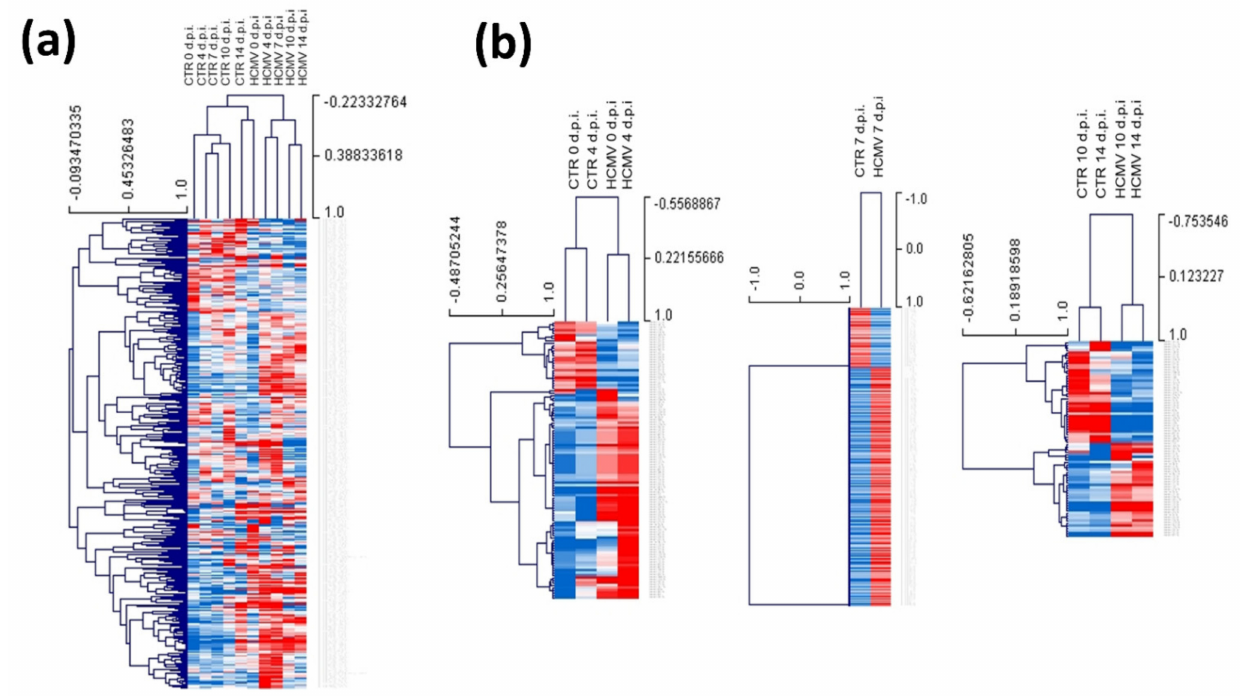
Figure 1. Heatmaps representing the expression of the analyzed microRNA (miRNAs) in human cytomegalovirus (HCMV) infected vs. control uninfected cells (CTR). All up-regulated (blue) and down-regulated (red) values are reported. The colors of the heatmaps were scaled by rows. ( a ) Total deregulated miRNAs at all times post infection (days post-infection; d.p.i.). ( b ) Most altered miRNAs (> ± 2 fold) subdivided for early (0 and 4 d.p.i.), intermediate (7 d.p.i.), and late (10 and 14 d.p.i.) times post infection.